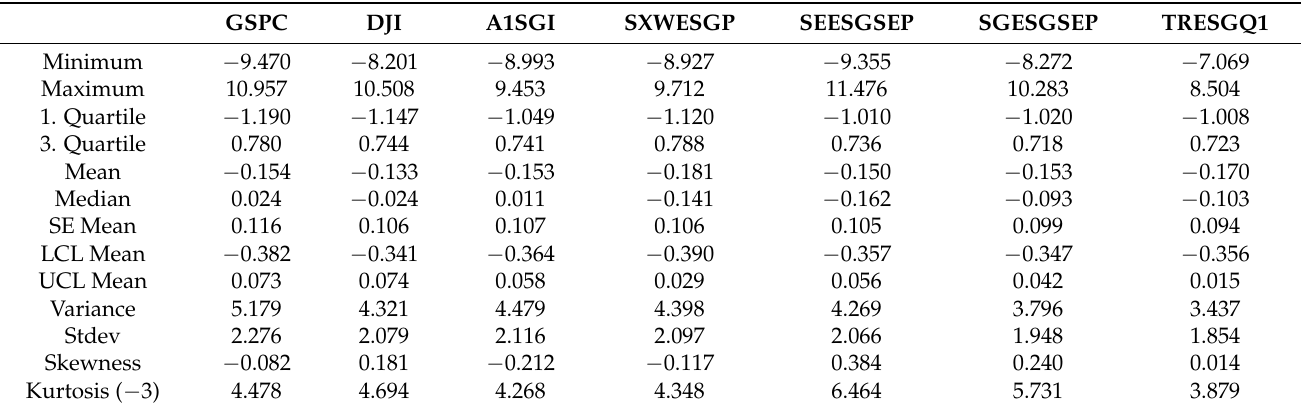
Figure 2. Kendall’s τ and copulas 3 July 2007–30 January 2009. Table 1. Descriptive statistics 3 July 2007–30 January 2009. The dependence between the S&P 500 and ESG indices and between the DJI and ESG indices is modeled by Student’s t and the Joe–Clayton copula (see Tables 2 and 3). There is one difference—the dependence between S&P 500 and SGESGSEP is described by the Joe–Clayton copula; between DJI and SGESGSEP by the t copula.